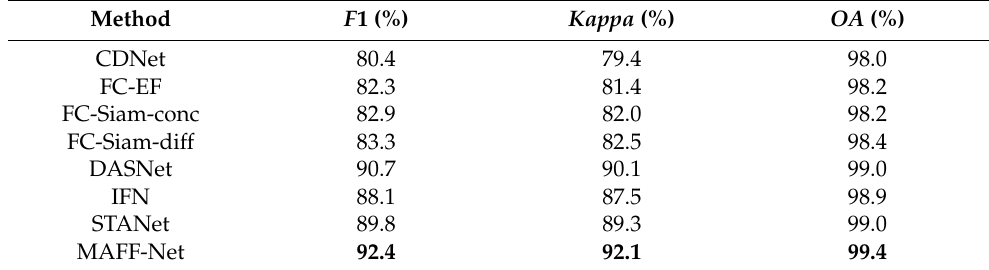
Table 4. Comparison of WHU-CD dataset results. The best scores are highlighted in